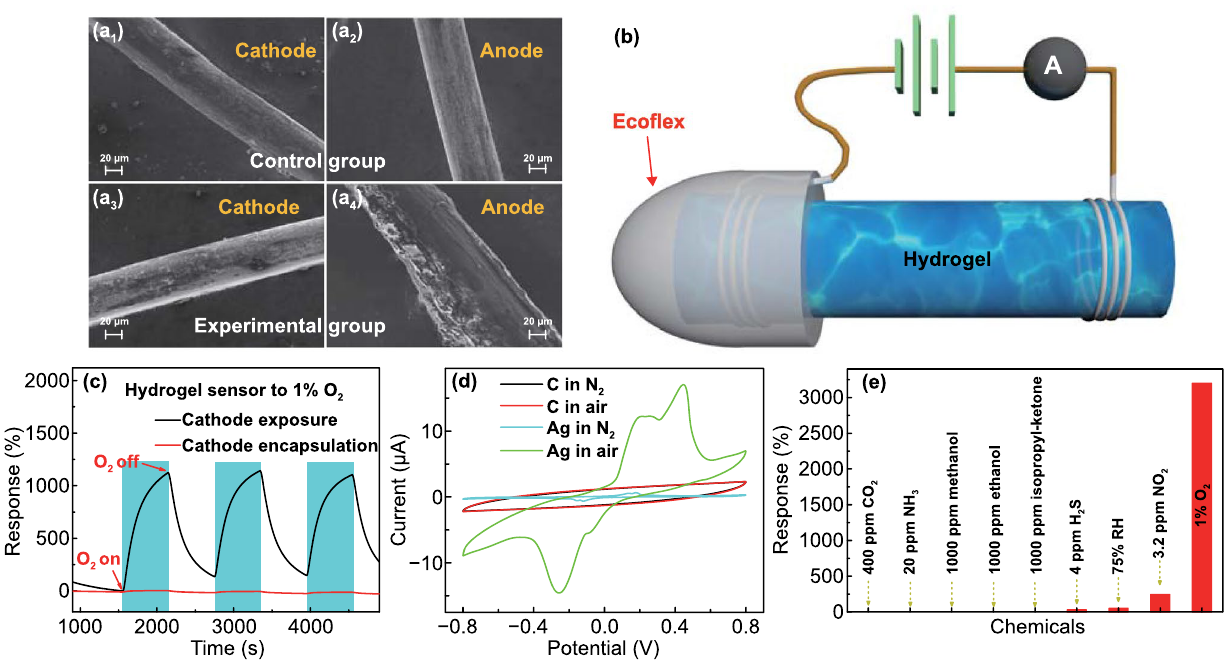
Fig. 6 a SEM images of (1) cathode and (2) anode in the control group, and (3) cathode and (4) anode in the experimental group after exposure to air for 5 h. b Schematic illustrating the device configuration in the cathode encapsulation experiment. c Dynamic responses of the sensor to 1% O 2 before and after encapsulation of cathode. d Current-Potential curves of the sensor when Ag and carbon (C) electrodes were employed in N 2 and air, respectively. e Comparison in the responses of the sensor to 400 ppm CO 2 , 20 ppm NH 3 , 4 ppm H 2 S, 3.2 ppm NO 2 , and 1% O 2